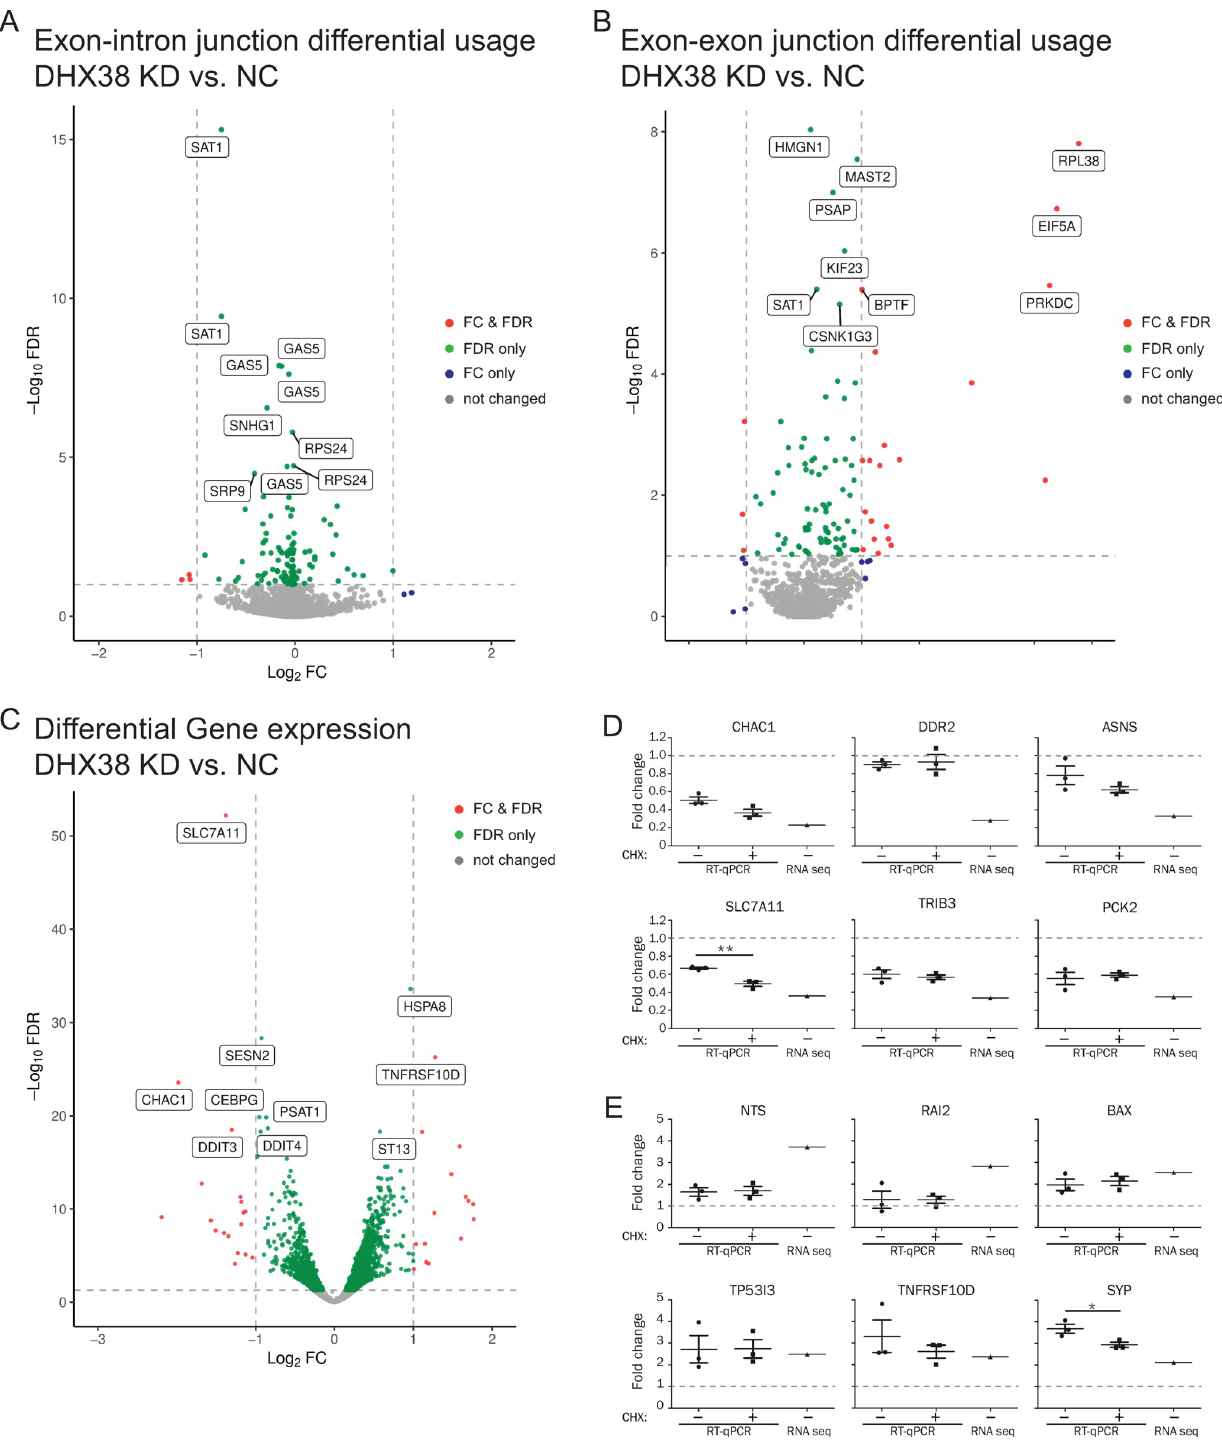
Fig 2. DHX38 downregulation changes primarily gene expression. Summary of three independent RNA-seq analysis of HEK293 cells treated either with anti-DHX38 siRNA or negative control siRNA. Analysis of (A) splicing efficiency, (B) alternative splicing and (C) gene expression. Expression of selected genes that were downregulated (D) or upregulated (E) after DHX38 downregulation was analyzed by RT-qPCR. RNA was isolated from control cells or cells treated with cycloheximide (CHX) to reveal potential targets of non-sense mediated decay. Average of three independent experiment with SEM is shown. Expression value determined by RNA-seq analysis is shown in the same graph for comparison (RNA seq).